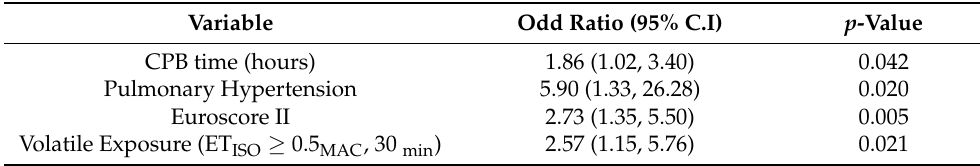
Table 5. Multivariate Logistic Regression Model for the Use of Inotropic/Vasopressor Medications in the Post-Bypass